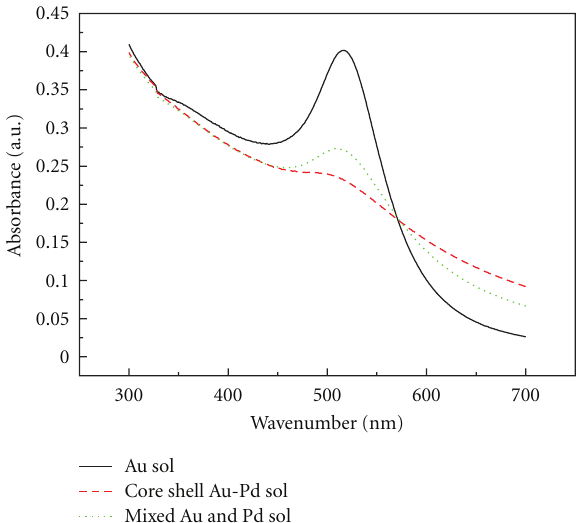
Figure 5: Linear sweep voltammogram of Au/C, core-shell Au- Pd/C, and Pd/C